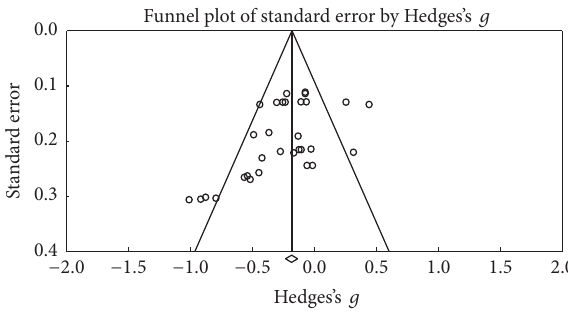
Hedges’s g Figure 16: Funnel plot for standard error in publications of Stroop